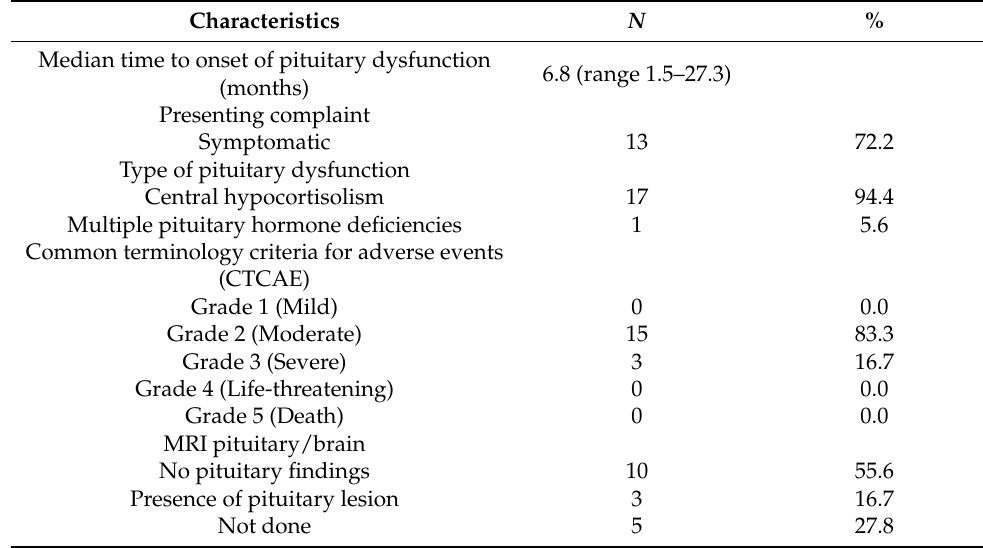
Table 3. Patients who developed pituitary dysfunction after immunotherapy ( n = 18).